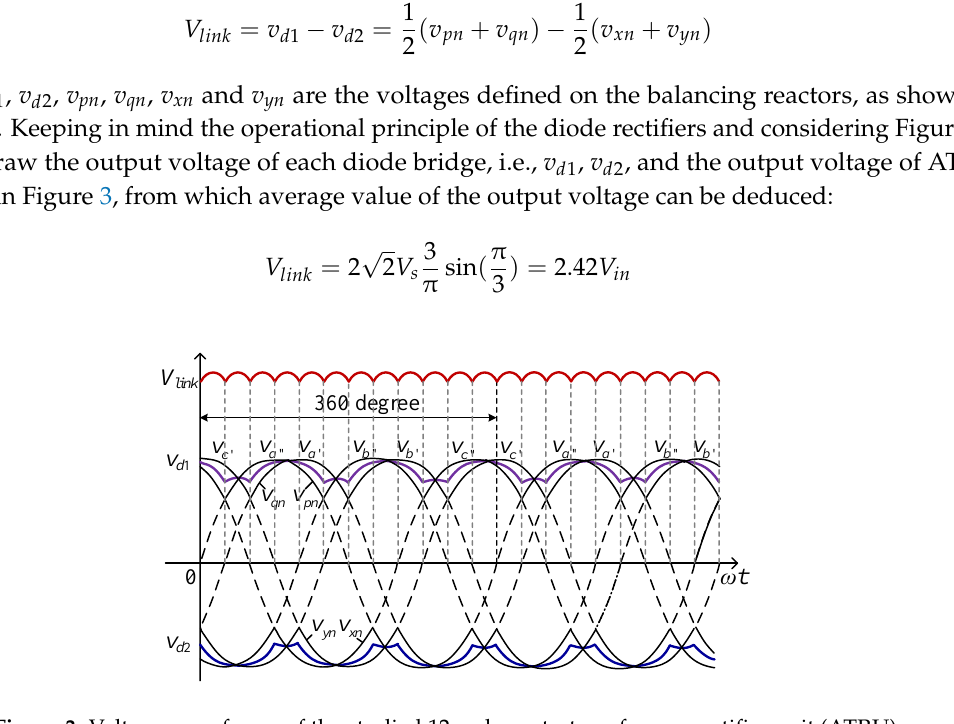
Figure 3. Voltage waveforms of the studied 12-pulse auto-transformer rectifier unit (ATRU).